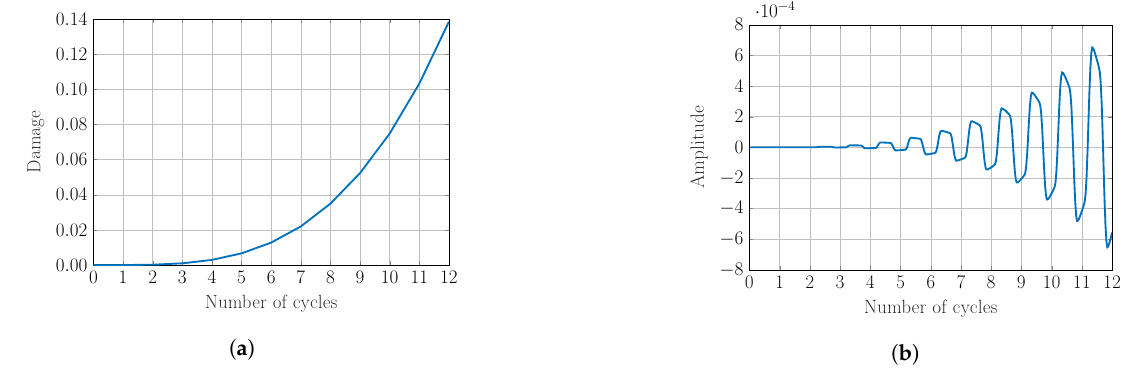
Figure 4. Damage evolution and the first PGD temporal mode in each cycle. ( a ) damage w.r.t. number of cycles; ( b ) first temporal function.